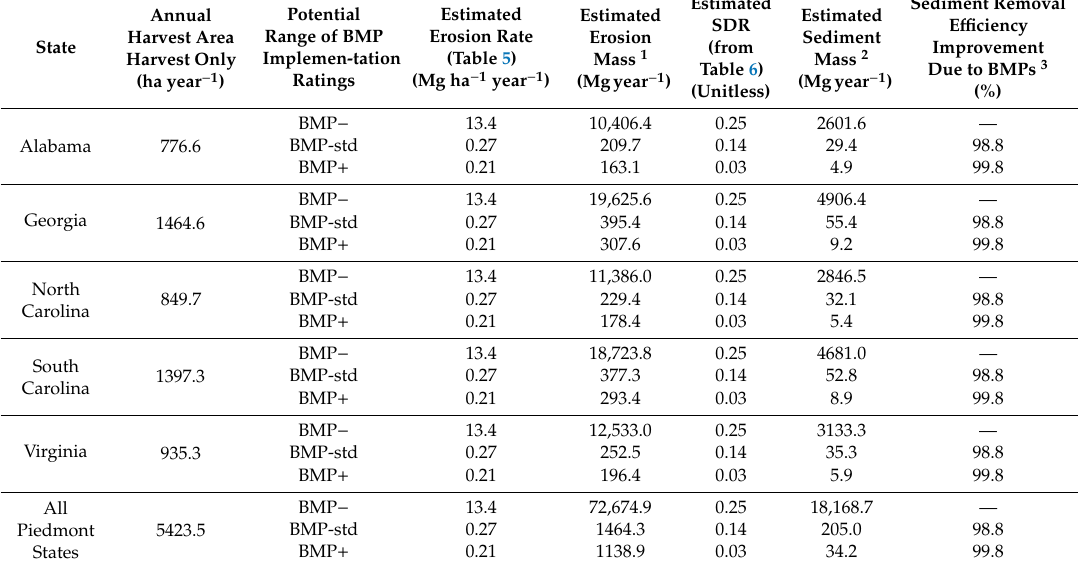
Table 12. Estimated erosion rates, erosion, masses, sediment delivery, and sediment removal e ffi ciencies due to BMP implementation levels by state for streamside management zones